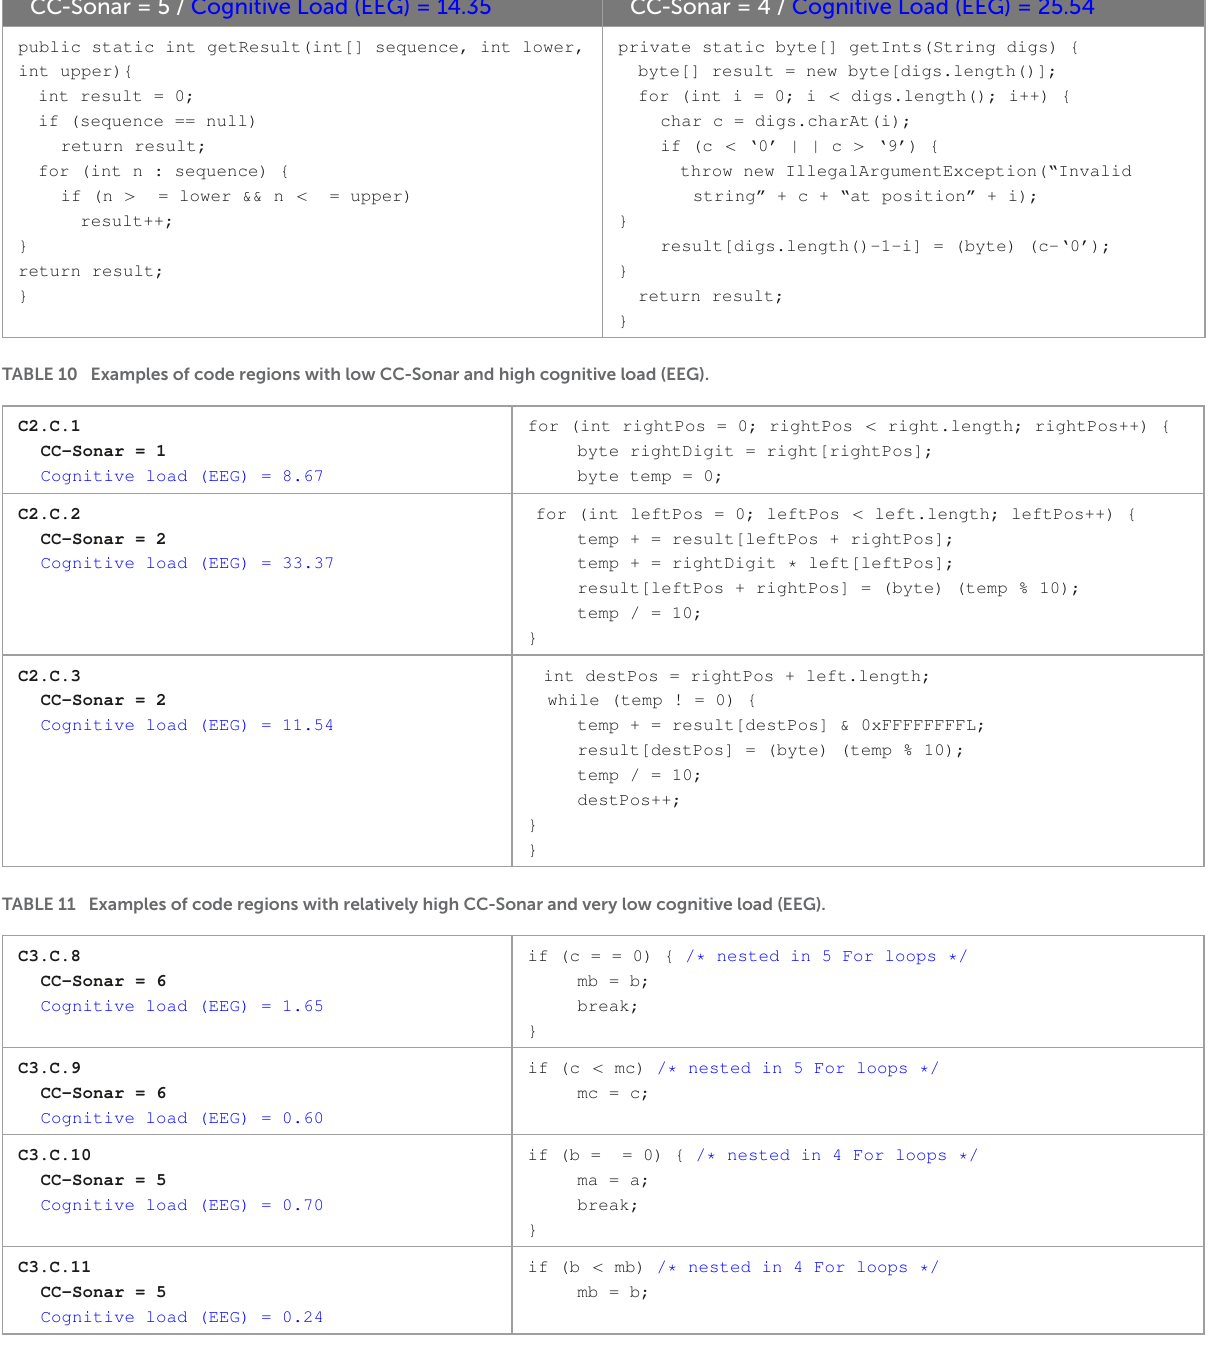
TABLE 9 Example of code that caused a divergence between CC-Sonar values and the cognitive load measured by EEG. C1.function CC-Sonar = 5 / Cognitive Load (EEG) = 14.35